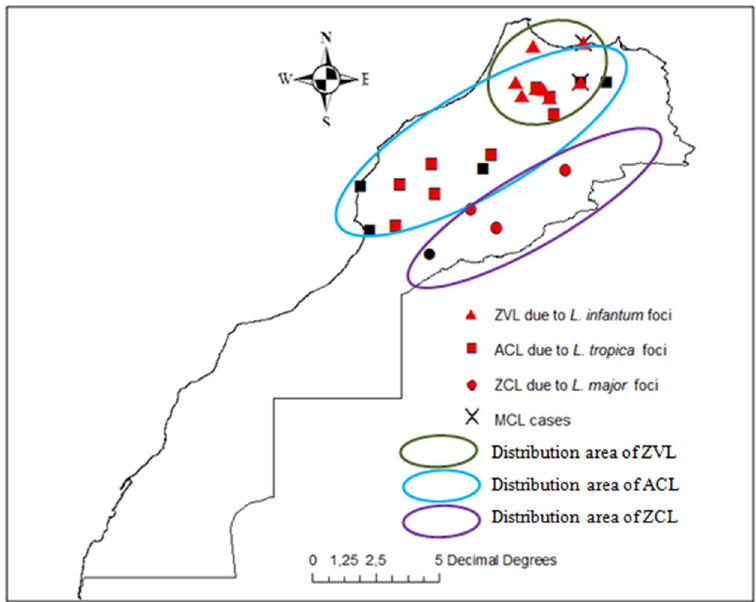
Figure 1. Geographical distribution of leishmaniases clinical forms in Morocco. Zoonotic visceral leishmaniasis (ZVL) Anthoponotic cutaneous leishmaniasis (ACL) zoonotic cutaneous leishmaniasis (ZCL) Mucocutaneous leishmaniasis (MCL).